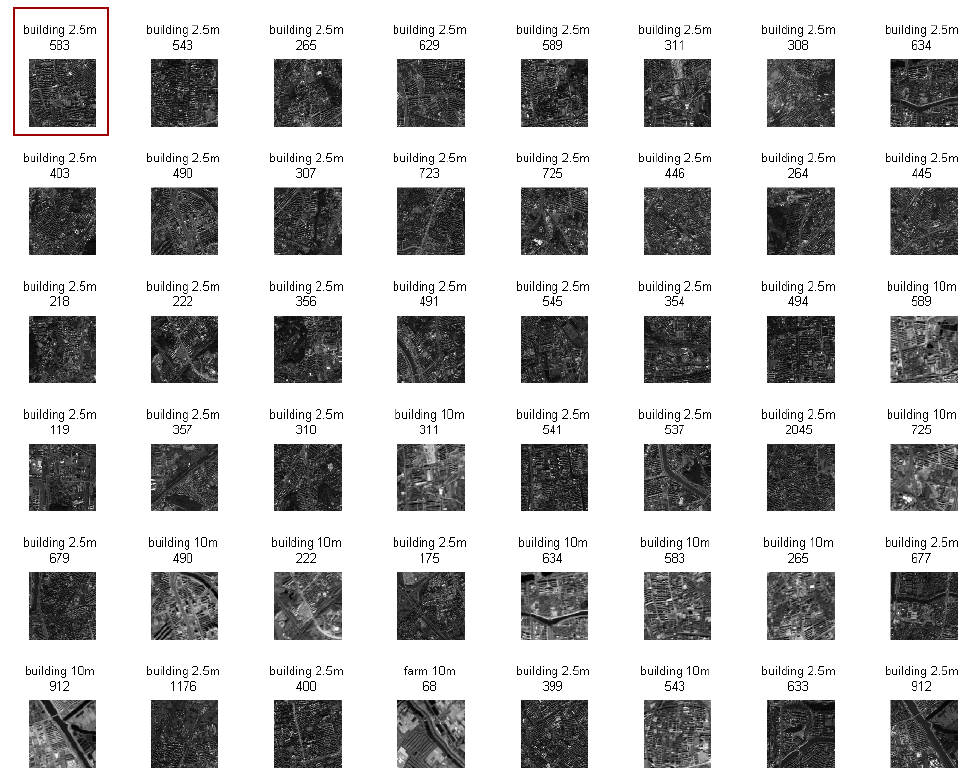
Figure 4: Retrieval results for an image patch of the Building class.